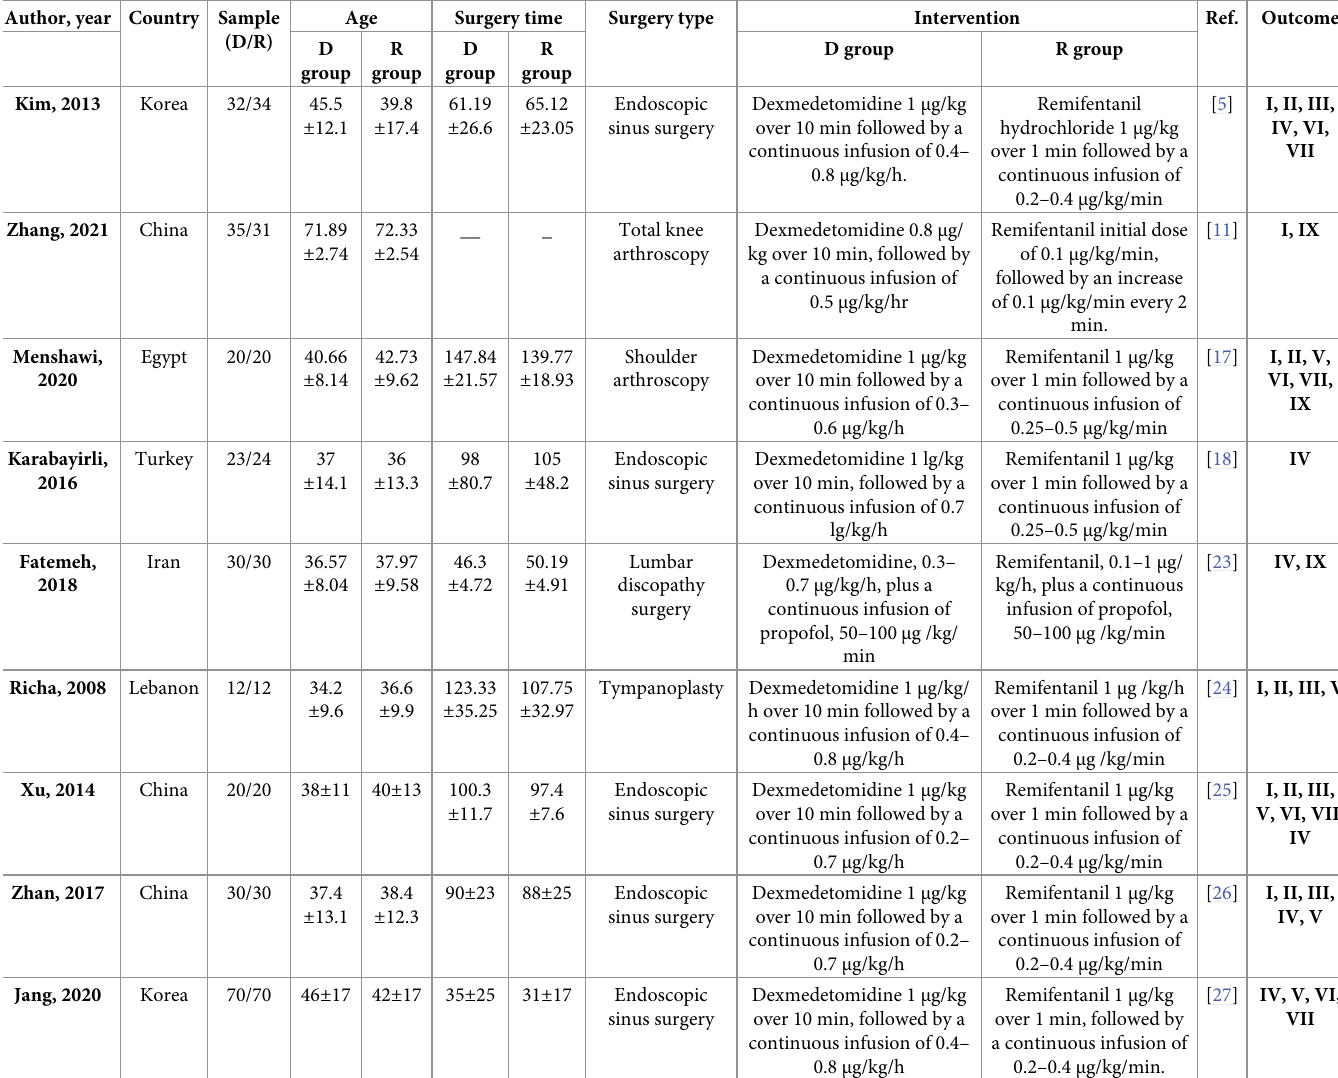
Table 1. Basic information concerning the included